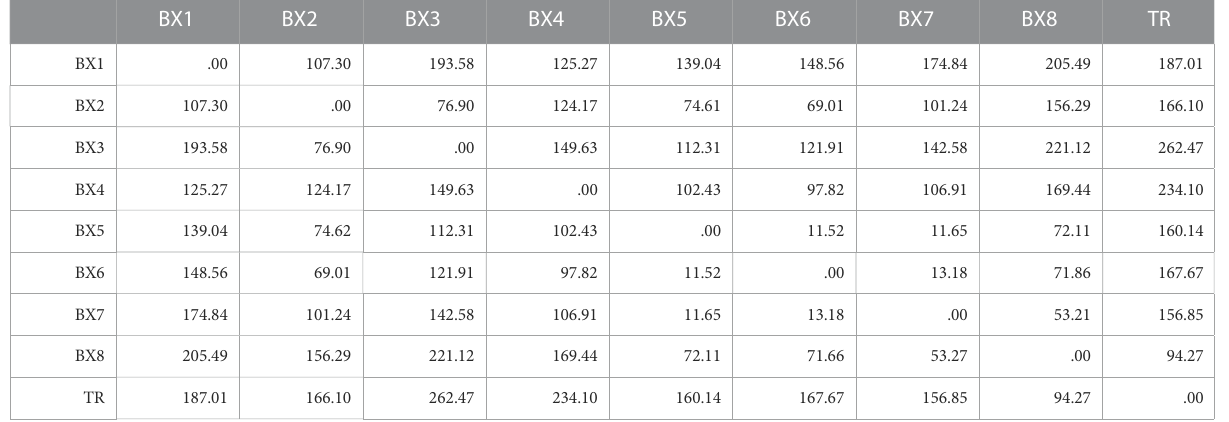
TABLE 4 Squared Mahalanobis distances (SMD) between the bauxite groups (BX1 — BX8) and soil